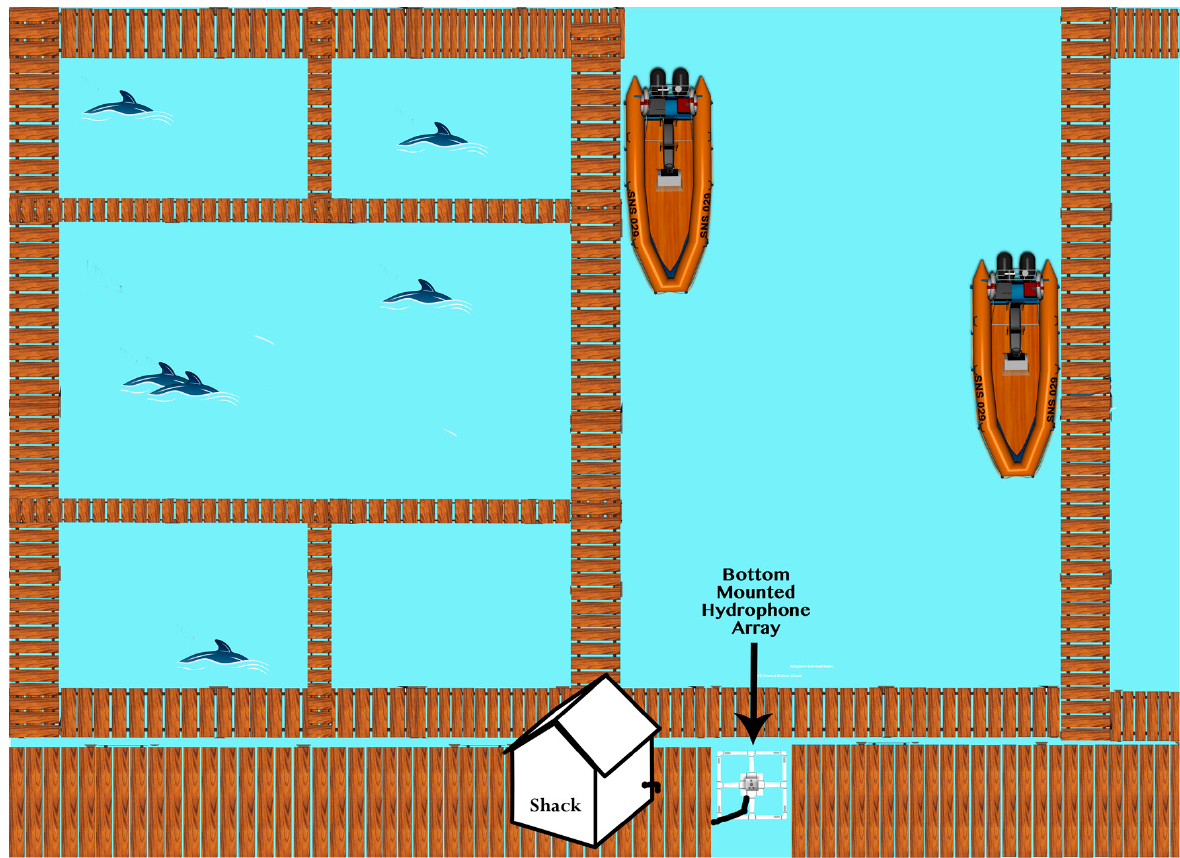
Figure 1. Aerial schematic of the general location of the bottom mounted hydrophone array in relation to the focal group of dolphins, and the shack that houses the sound card and computer components.